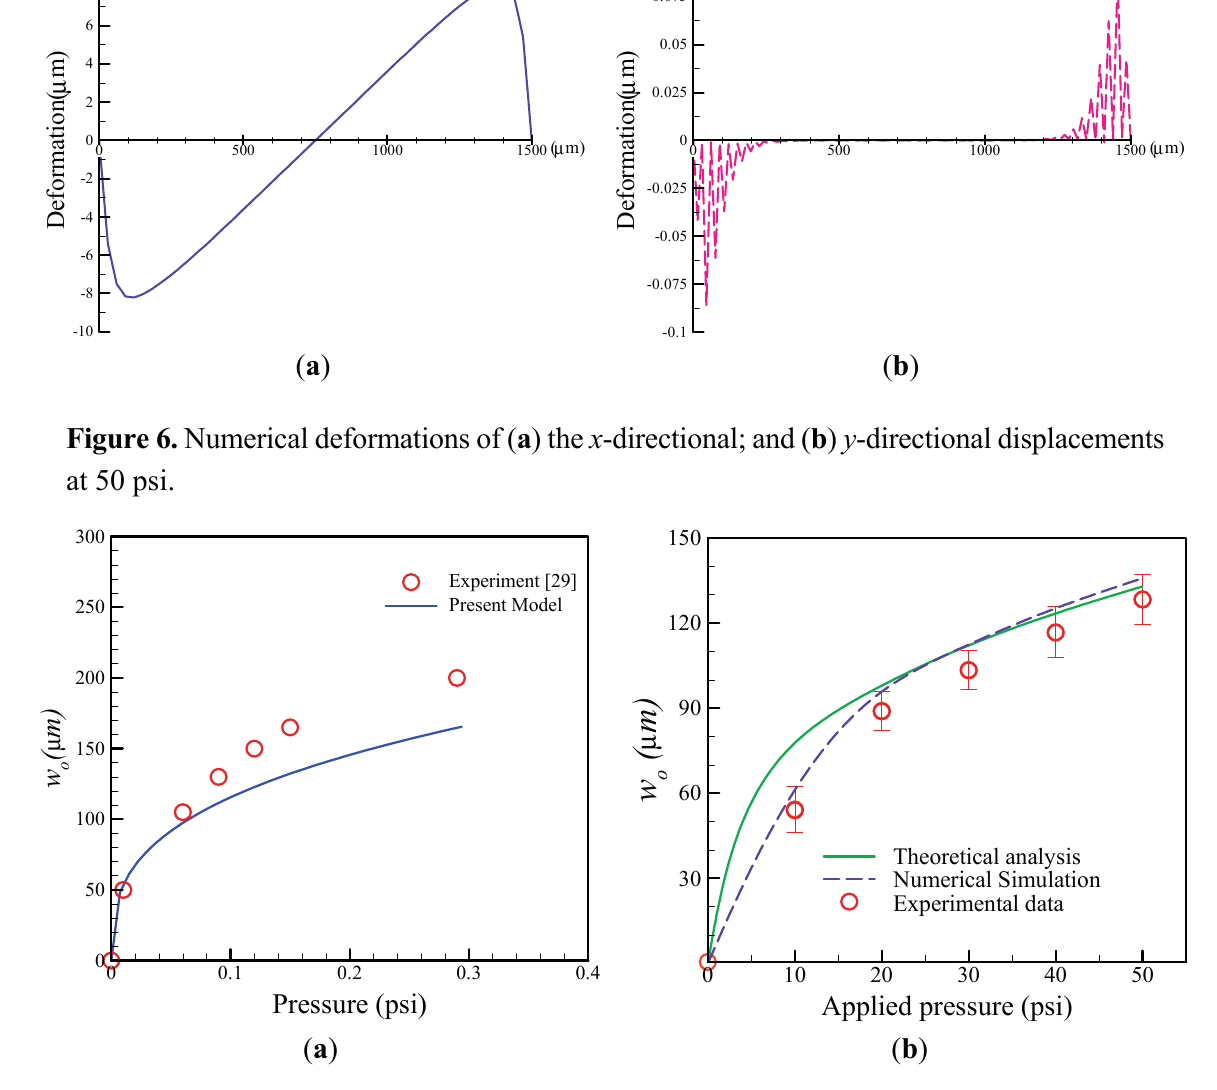
Figure 7. ( a ) Comparison of the present model and experimental data for maximum deformation; ( b ) Comparison of theoretical analysis, numerical simulation and measured data for maximum deformation of membrane at various air